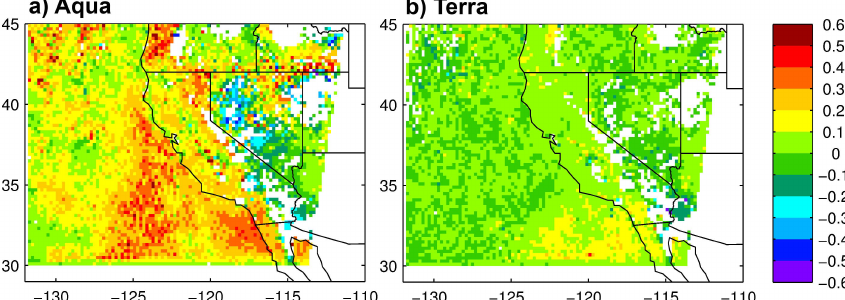
Fig. 10. Fractional error reductions from non-assimilated to NASA NNR assimilated models computed with respect to NASA NNR Aqua (a) and Terra (b) observations. Model fields used for comparison are forecasts at 21:00 and 18:00UTC for (a) and (b) respectively. Thus in the fractional error computation, observed data has not been assimilated yet and can be considered as independent. Thus, (a) and (b) are fractional error reductions for a 3 and 21h forecast respectively (see Sect. 2.4 for more details).